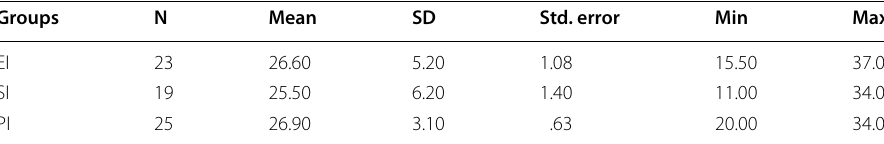
Table 3 One-way ANOVA on GLPT Sum of squares df Mean square F Sig. Between groups 21.84 10.92 .45 .63 Within groups 1548.30 24.19 Total 1570.15 66